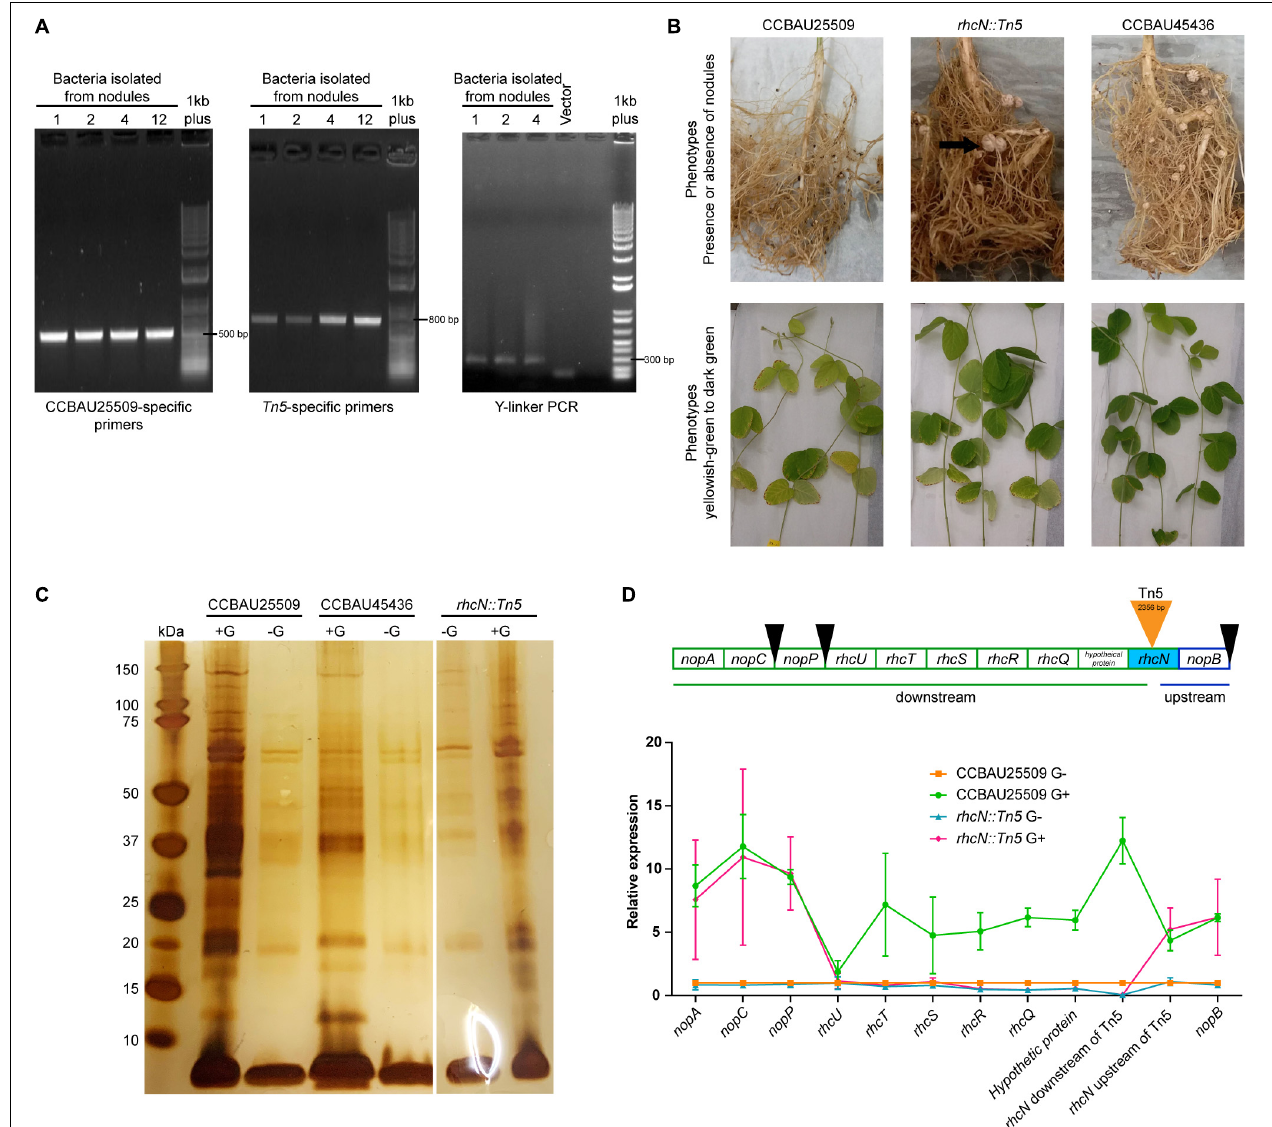
FIGURE 5 | Characterization of the rhcN:Tn5 mutant. (A) PCR was performed to confirm that the rhcN:Tn5 mutant originated from CCBAU25509 (using CCBAU25509 primers) and contains a Tn5 insertion (using Tn5 primers and Y-linker PCR). Numbers 1, 2, 4, and 12 are rhizobia isolated from independent nodules. However, they were probably the same insertional event since the junction sequences were identical. Last lane on each gel is the 1 kb Plus DNA Ladder (Invitrogen). (B) Performance of the rhcN:Tn5 mutant inoculated onto the soybean accession C08 that carries the Rfg1 allele. Formation of root nodules (indicated by black arrows) and the leaf color (pale green or dark green) when the plants were grown under nitrogen-limiting conditions were recorded for the rhcN:Tn5 mutant, the non-compatible parent strain CCBAU25509, and the compatible strain CCBAU45436 28 days post-inoculation. (C) Silver staining visualization of the NuPAGE 4–12% bis-tris gel of the precipitated extracellular proteins from CCBAU25509, CCBAU45436 and the rhcN:Tn5 mutant with and without genistein (G) induction. (D) Upper panel: genes upstream and downstream of the rhcN operon. Black wedges indicate the upstream tts box sequences. Lower panel: relative expression patterns of these genes in CCBAU25509 and in the rhcN:Tn5 mutant with and without genistein (G). GyrA was used as the reference gene. Each data point represents the mean of three independent biological replicates. Error bar: standard